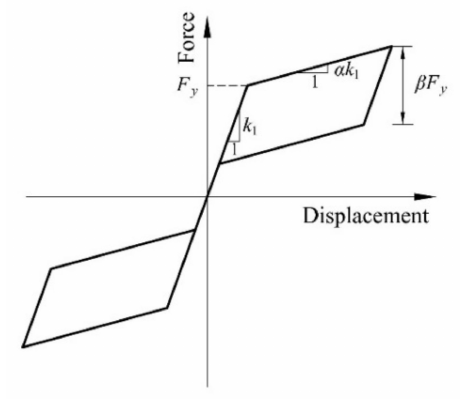
Figure 1. The force-displacement relationship of the self-centering (SC) SDOF system with flag- shaped hysteretic behavior. Note: k 1 = initial stiffness; α = post-yield stiffness ratio; β = energy dissipation parameter; F y = yield